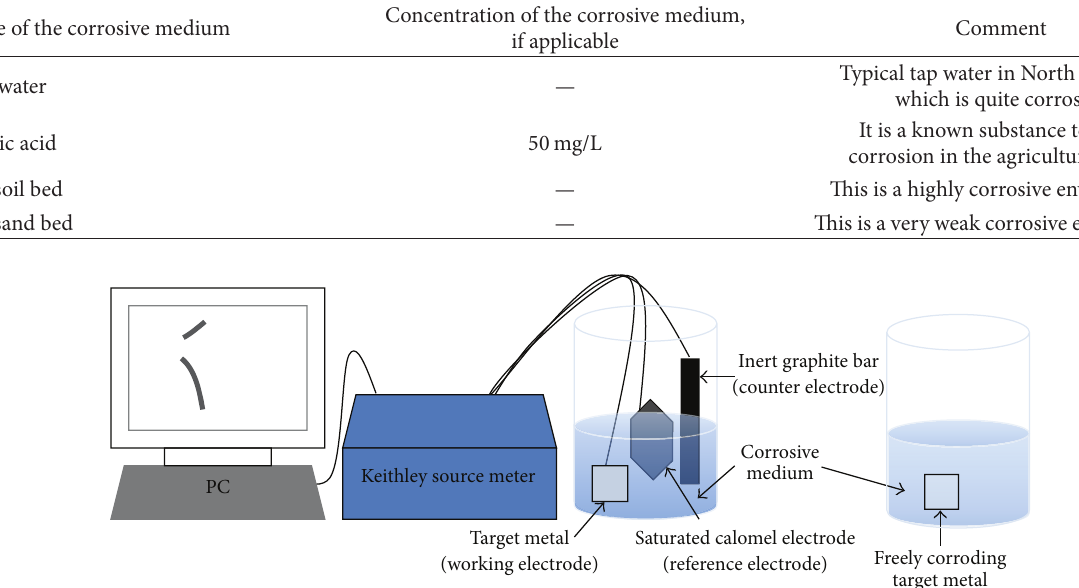
Figure 5: A simple experimental set-up to validate the proposed adaptive loop. A simple and cost-effective DC source meter controlled with the LabVIEW (cid:2) VI is used for the